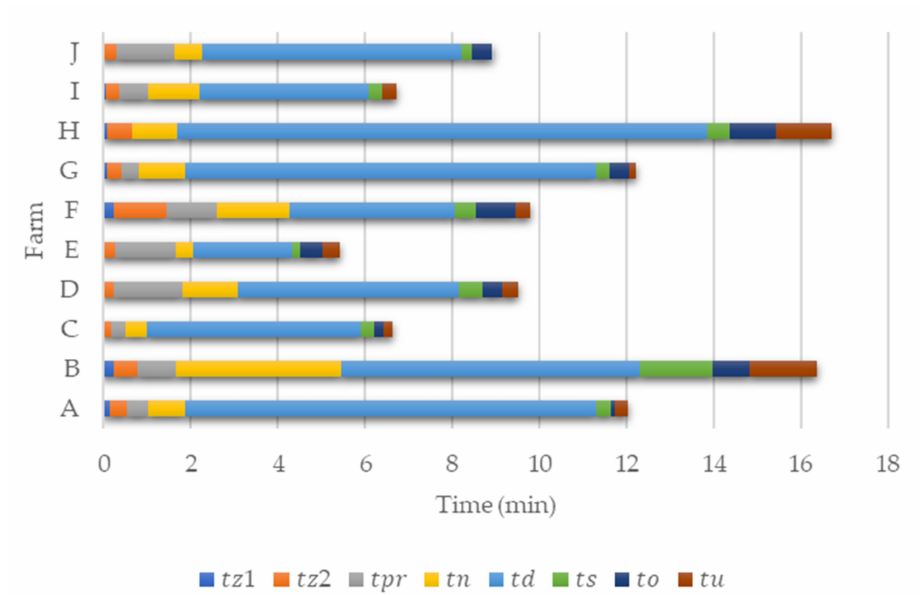
Figure 1. Average time spent in the milking parlor for a group of goats T d1g (min), as schedules of milking operations at all analyzed goat farms ( t z 1 —the time of moving a group of goats to the milking parlor (min); t z 2 —the time of arrangement of goats on the milking stalls (min); t pr —the time of preparation for milking (min); t n —the time of placement of teat cups (min); t d —the time of one milking (min); t s —the time of removing the milking cluster (min); t o —the time of treatment (disinfection of teats) after milking (min); t u —the time a group of goats leaves the milking parlor (min).